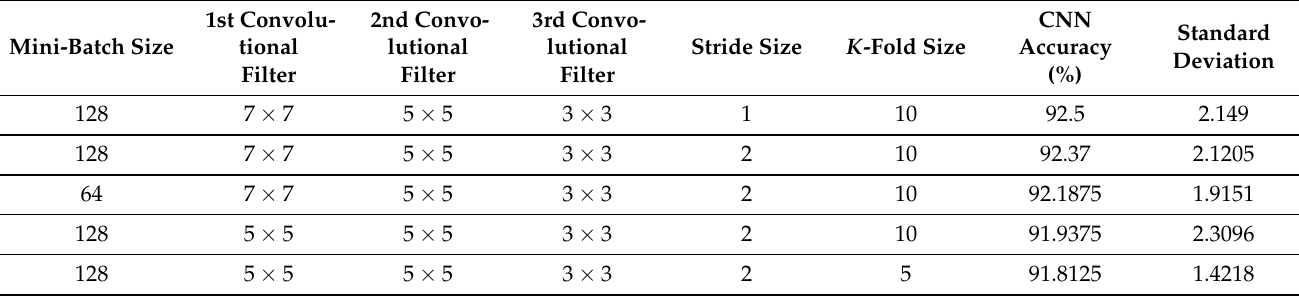
Table 2. CNN architectures tested in classifying the 14,684 viruses in their realms. The architecture chosen in this experiment was used in the other experiments in this